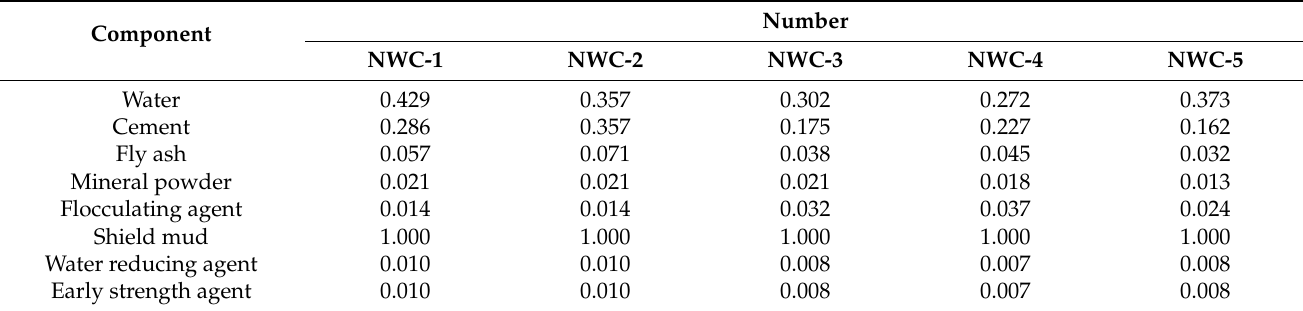
Table 5. Mix Proportion of NUC-FM (kg).